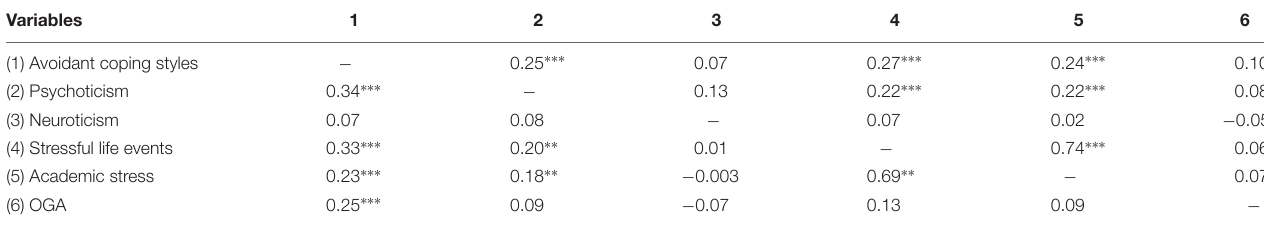
TABLE 3 | Correlations between stressful life events, coping strategies, personality traits, and OGA for males ( N = 298) and females ( N = 356). Variables 1 2 3 4